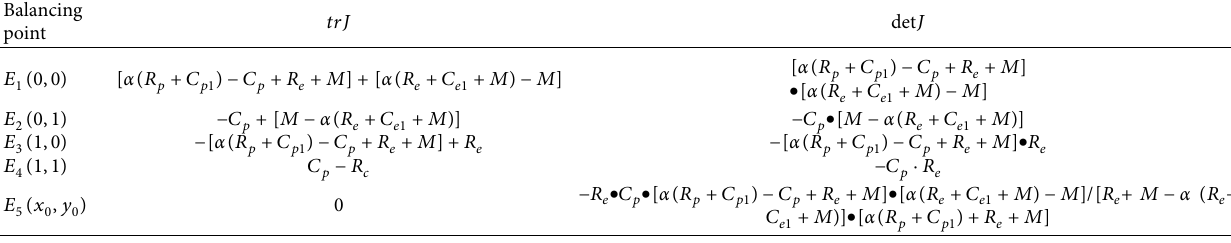
Table 2: Traces and determinants of the Jacobian matrices at the balancing points.